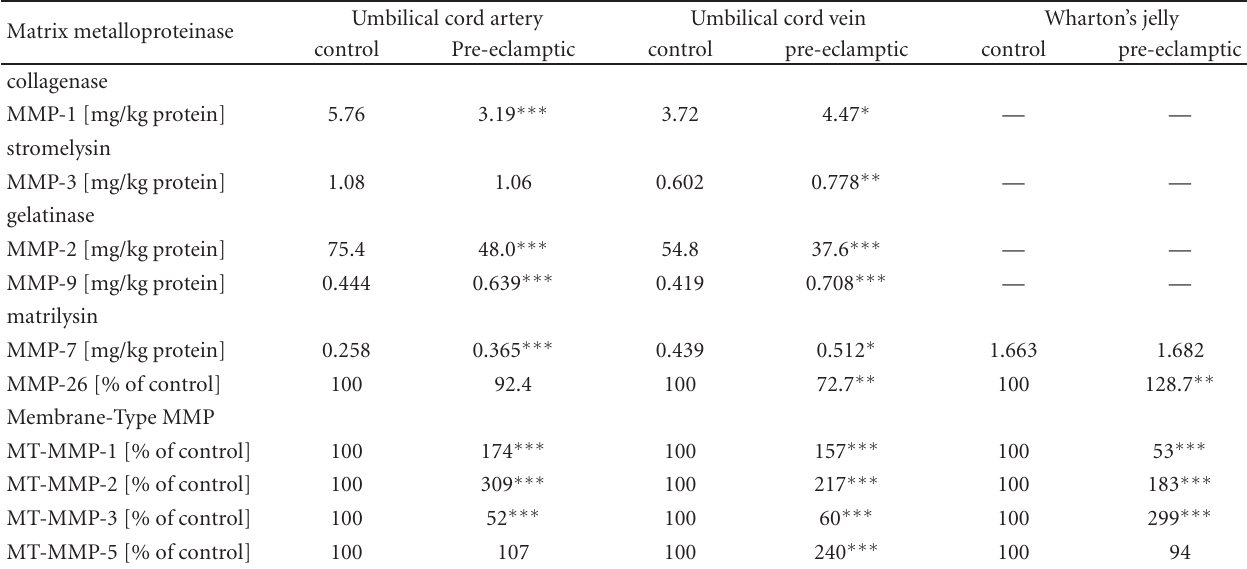
Table 1: Matrix metalloproteinases of umbilical cord tissues in pre-eclampsia ( n = 10, ∗ P < . 05, ∗∗ P < . 01, ∗∗∗ P < . 001). Matrix